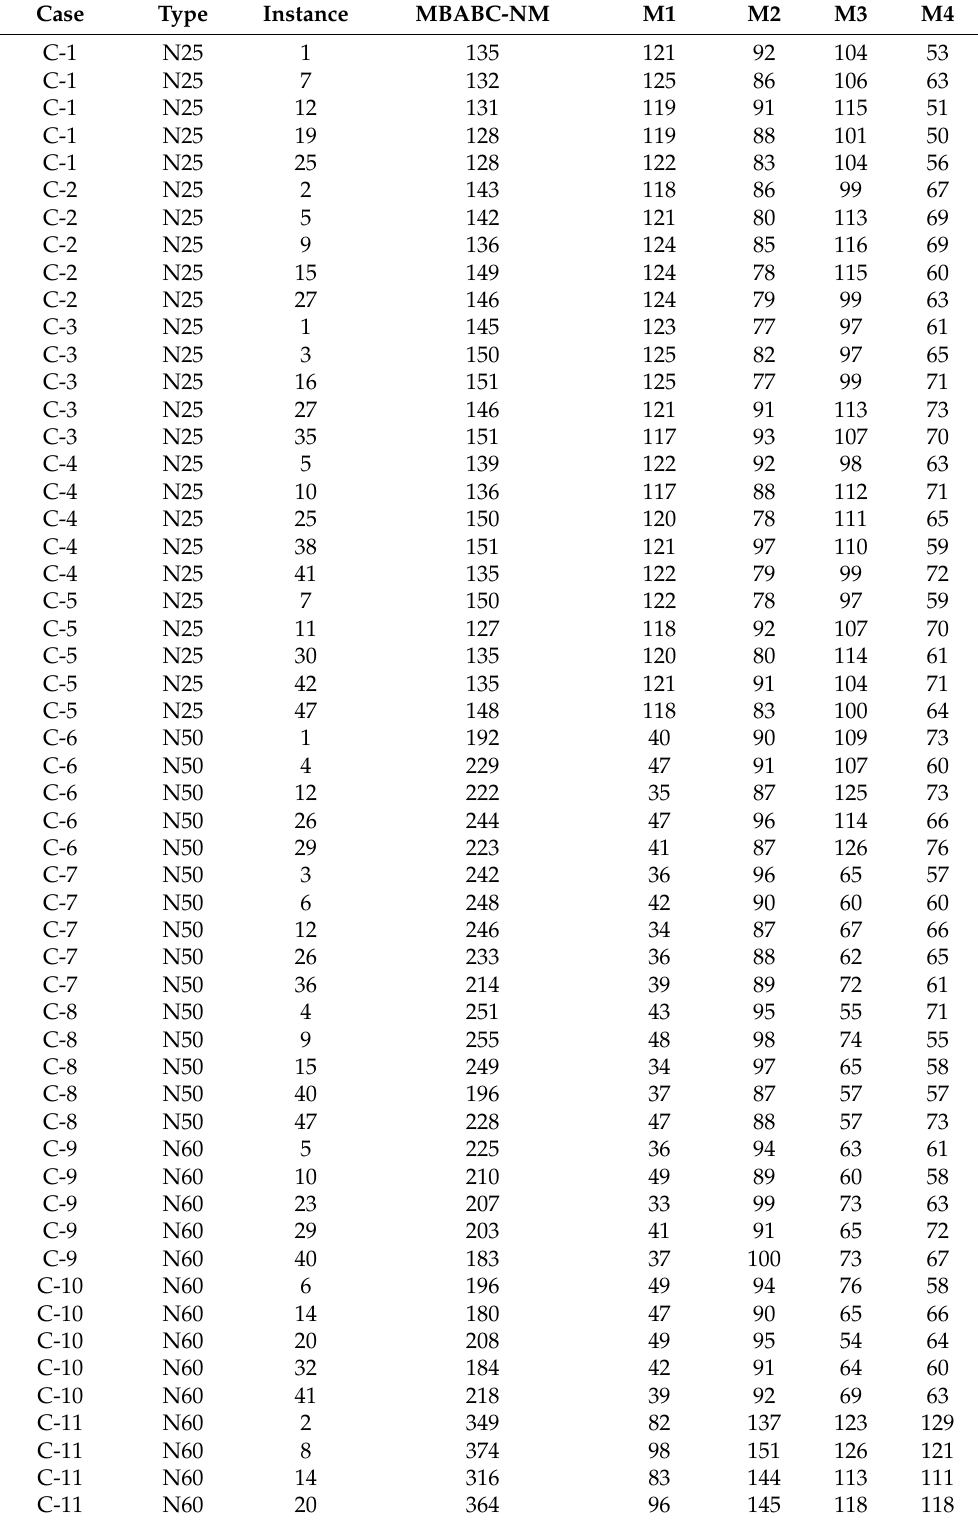
Table 1. Our proposed algorithm achieved minimized Euclidean distance among the Pareto solutions. Table 5. Experimental result of NSP dataset in terms of